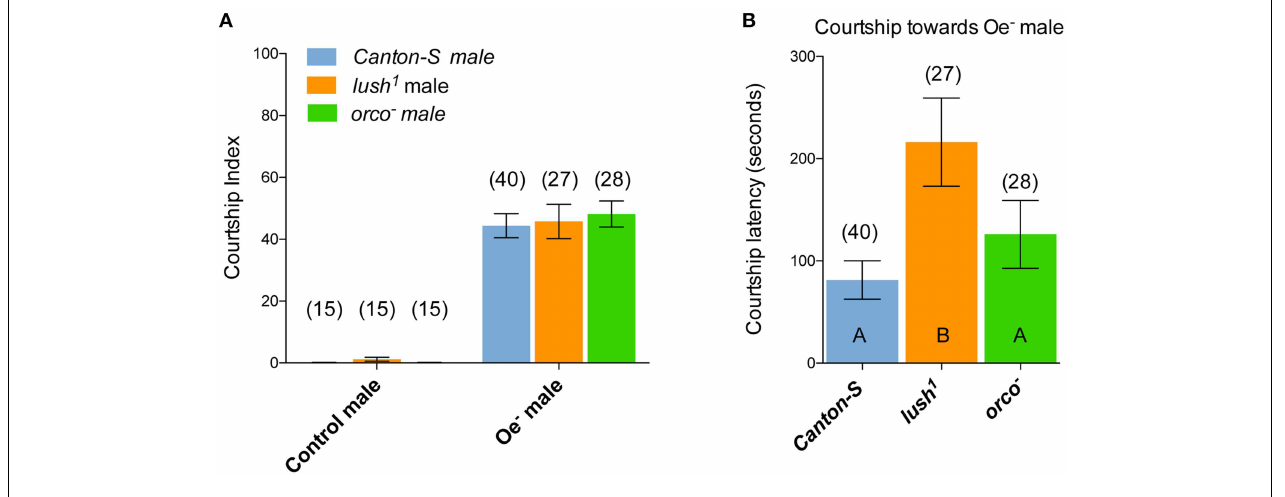
FIGURE 4 | Lush is not required for the sensing of identified stimulatory male or females CHs. (A) Male–male courtship index in pairs consisting of 2 virgin males of the indicated genotypes. (B) Latency to initiate